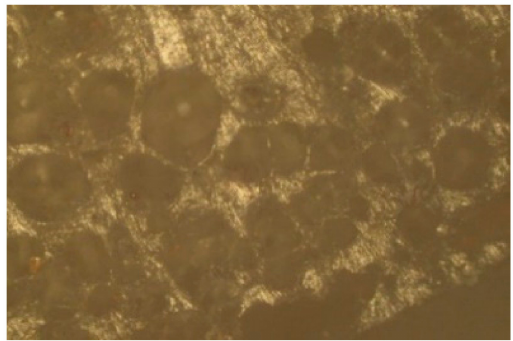
Figure 4. Element of the active filling.